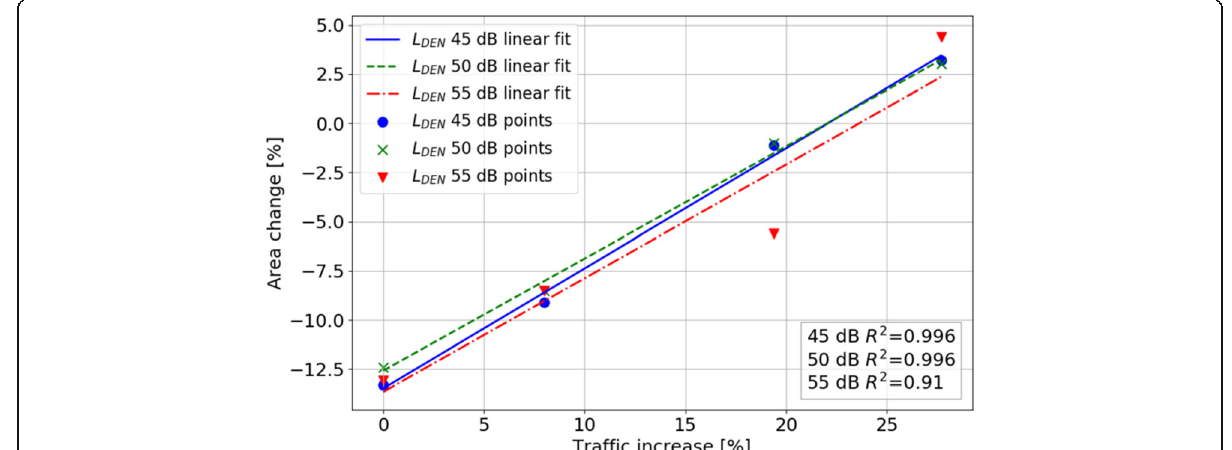
Fig. 7 Linear regression of the contour area changes for the L DEN values listed in Table 5